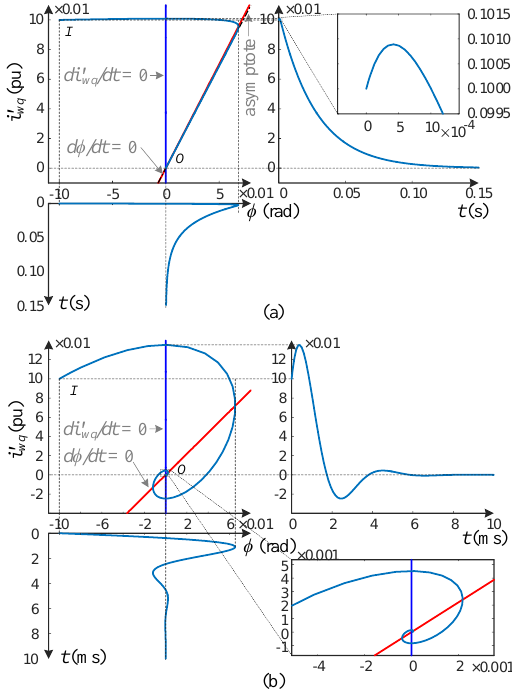
Figure 9. Convergence process of the second-order simplified system composed of Equations (22) and (23), from the initial point I . ( a ) k p 3 = 0.6, k i 3 = 50; ( b ) k p 3 = 0.3, k i 3 = 2000.